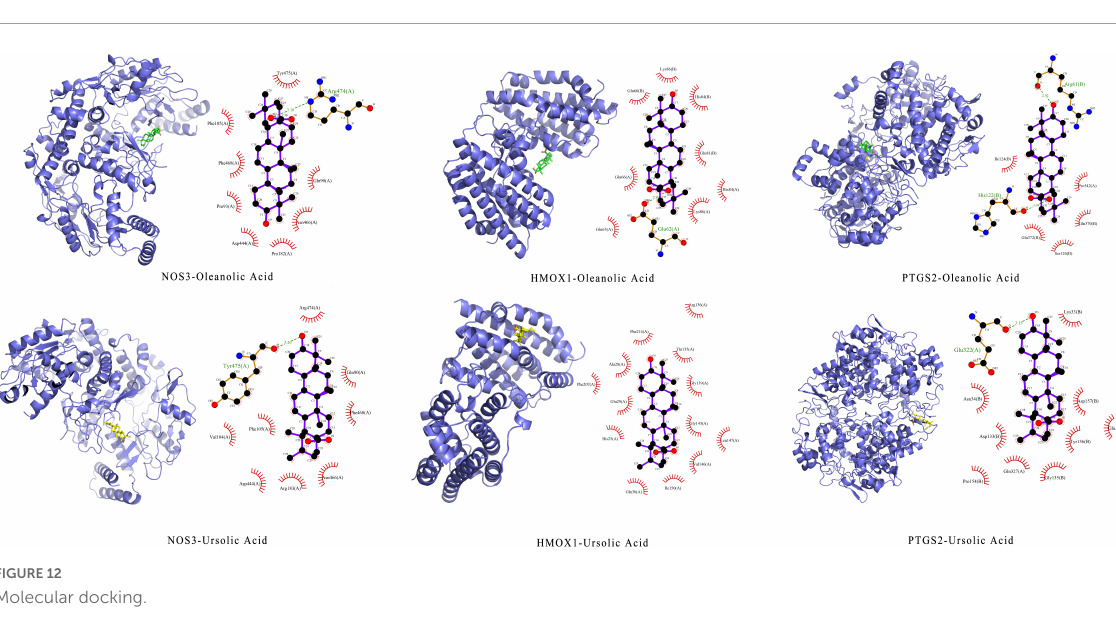
FIGURE12 Molecular